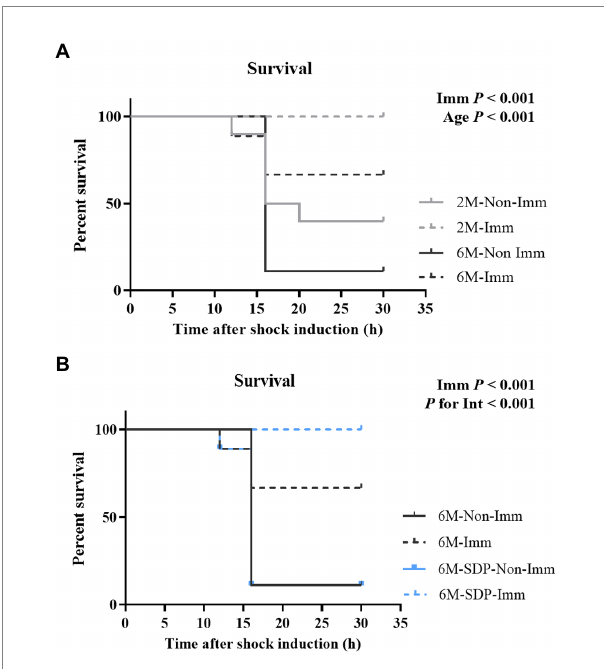
FIGURE 6 Survival rates of mice exposed to a lethal shock with SEB and LPS. Panel (A) compares 2-month-old (2 M) mice and 6-month-old mice fed control feed (6 M). Panel (B) compares 6-month-old mice fed control feed and 6-month-old mice fed SDP feed (6 M-SDP). Results are expressed as percent of survival ( n = 9–10 animals). Statistics: log-rank (Mantel-Cox) test. Int indicates the interaction between immunization (Imm) and age-feed factors. LPS, lipopolysaccharide; SDP, spray-dried porcine plasma; SEB, S. aureus enterotoxin